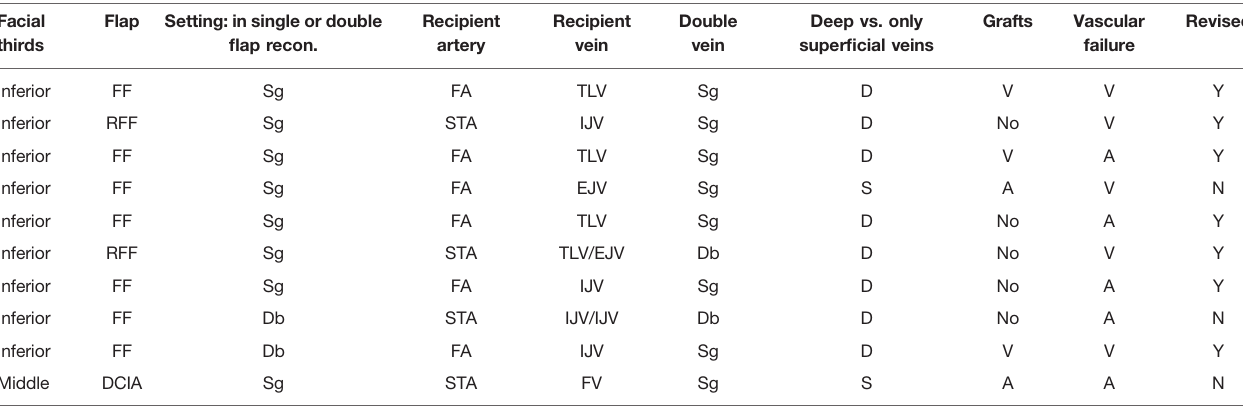
Flap Setting: in single or double